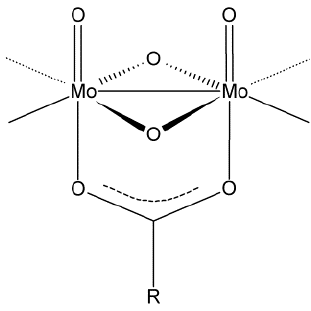
Figure 2. A molecular formula of 2,2-dimethylsuccinic acid, dmsH